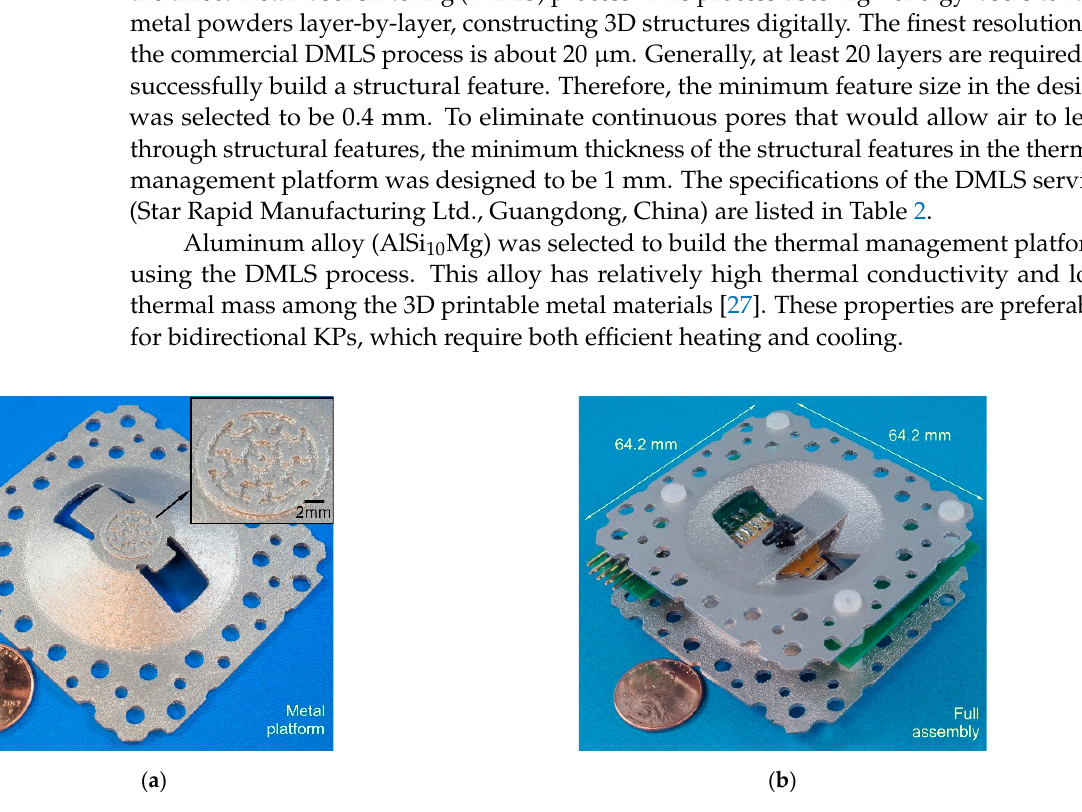
Figure 6. Photos of a 3D-printed bidirectional KP: ( a ) 3D-printed thermal management platform using DMLS process; ( b ) fully assembled KP.